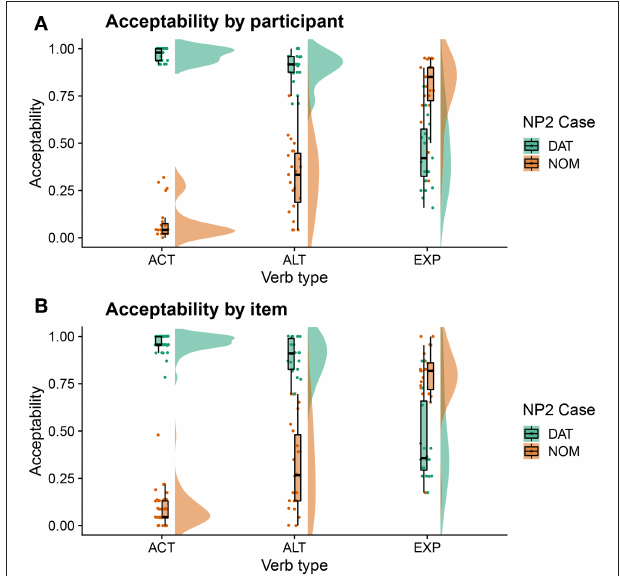
FIGURE 1 | Acceptability judgements including by-participant (A) and by-item (B) variability. Individual data points represent the mean by-participant/by-item acceptability of the verb and case